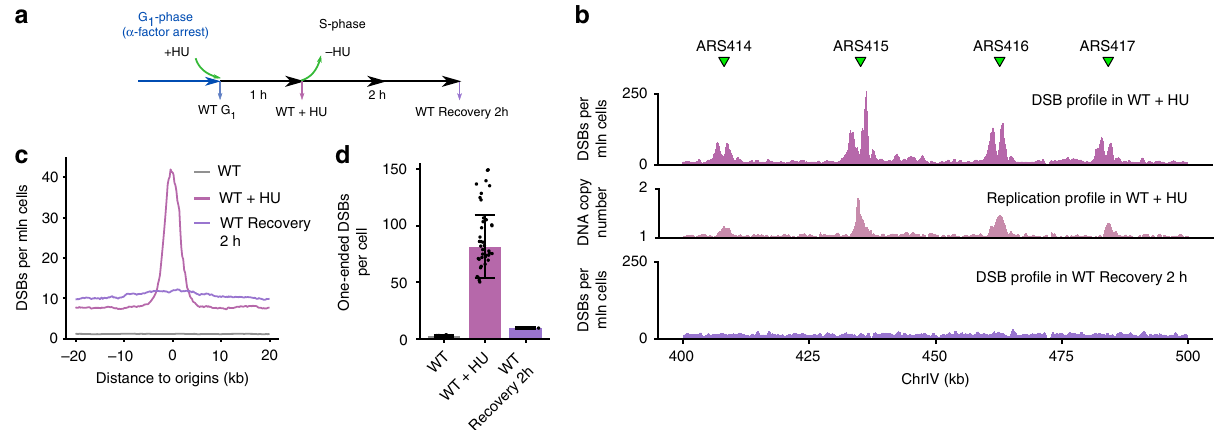
Fig. 4 Quanti fi cation of replication stress-associated DSBs. a Schematic representation of hydroxyurea (HU) experiments. Cells were arrested in G 1 -phase with α -factor, treated with HU before release to S-phase, collected after 1 h or resuspended in fresh medium and collected 2 h after removal of HU. b Example of quanti fi ed DSB data after 1 h HU treatment and 2 h recovery from HU. Replication origins are marked with green triangles, absolute frequencies of DSBs for a fragment of chromosome IV are shown in a million cells. As a control, replication pro fi le in WT + HU sample (number of gDNA reads in a 500 bp in the sample normalized to untreated G 1 -phase sample) is shown. c Meta-pro fi le of DSBs around active replication origins under HU treatment, de fi ned as 144 origins with fi ring time <25 min (early origins, fi ring time according to Yabuki et al. 39 ). Median of DSB densities, expressed as DSBs per million cells in 2 kb window around each early origin, was calculated and the background was removed as described in Methods. d Quanti fi cation of one-ended DSBs. One-ended DSBs per cell values were calculated as described in Methods and SD for WT and WT + HU was calculated using individual NotI cutting sites ( n = 39, Methods) and for Recovery 2 h using SD of background noise and assuming Poisson distribution of fragment counts (Methods). Individual data points are visualized as black dots; source data are provided as a Source Data fi